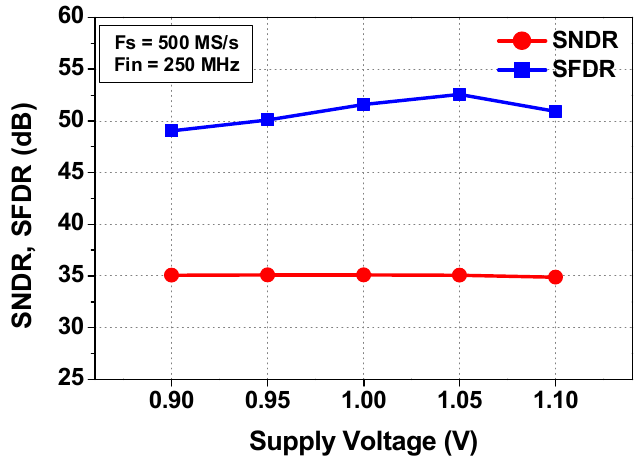
Figure 14. Measured SNDR and SFDR with various ( a ) input frequencies at 700 MS/s, ( b ) sampling rates with a 20 MHz input.